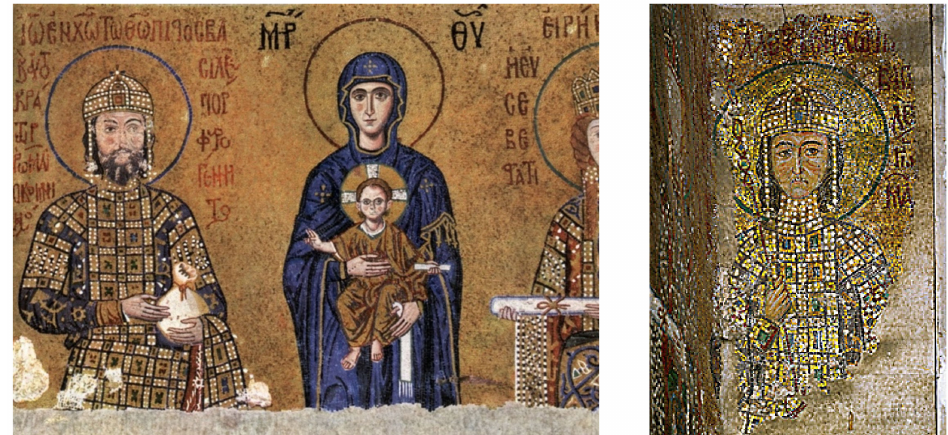
Figure 1. John and Piroska-Eirene, with their son Alexios; mosaic; post 1119; Istanbul, Ayasofya, south gallery. Published in [2] (p. 147), [3–5] (p.